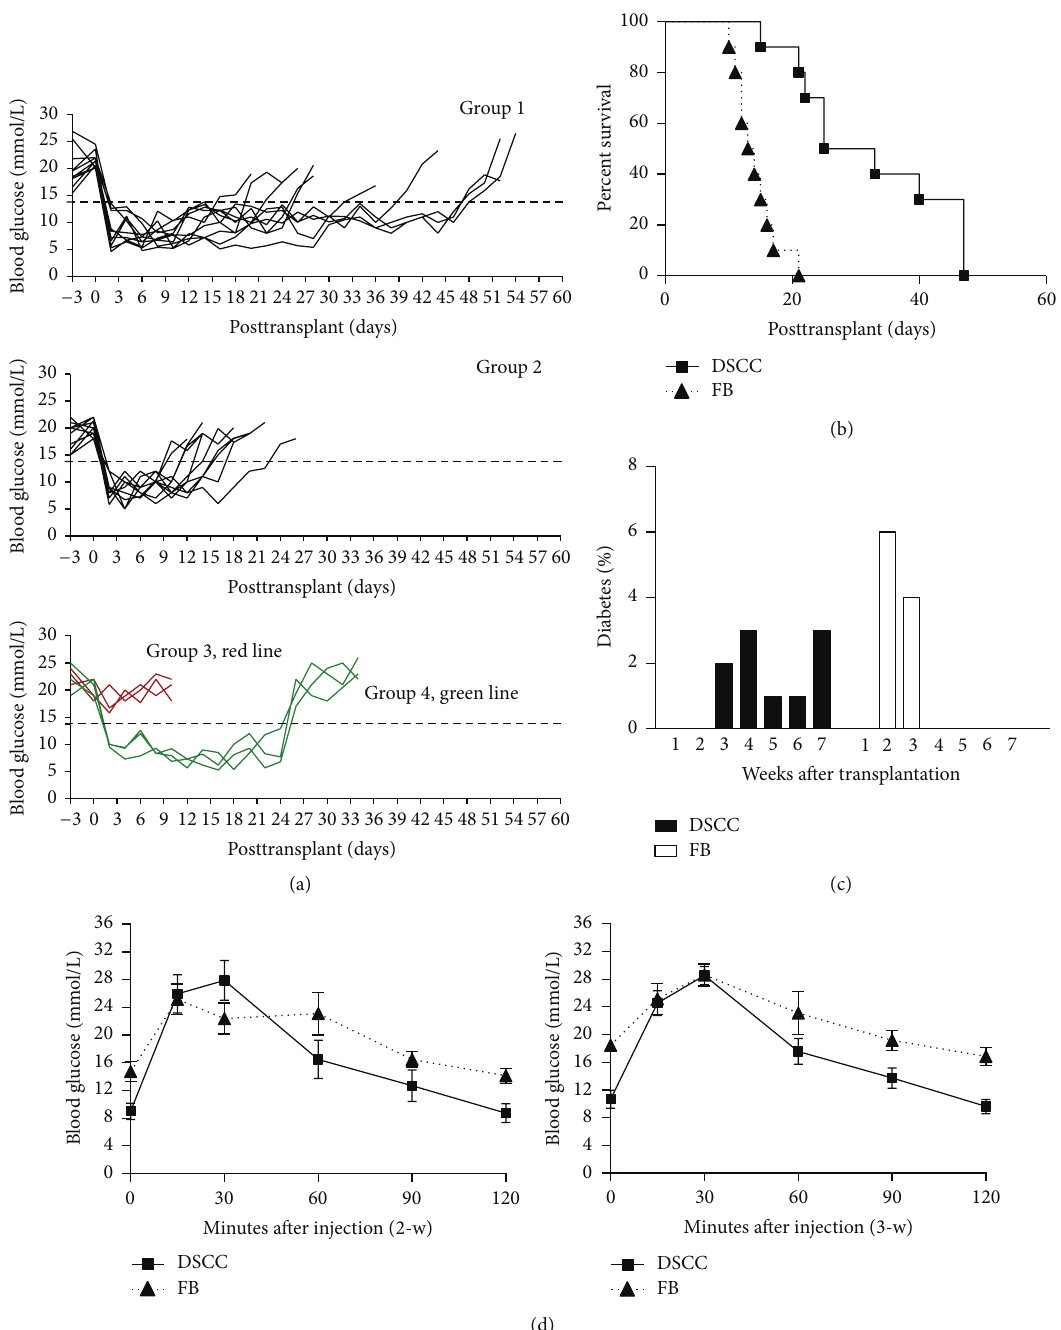
Figure 2: DSCC prolongs mouse islet allograft survival. (a) Blood glucose level in B6 mice before and after transplantation. Diabetes was induced by a single injection of streptozotocin in B6 mice. Mice in groups 1, 2, and 4 returned to normal glucose levels after transplantation with 400 islets from Balb/c donors in a collagen matrix with DSCC (groups 1 and 4) or FB (group 2) cells. Mice in group 3 (DSCC only) did not normalize high glucose after transplantation (red line). (b) Significantly prolonged euglycemia in diabetic B6 mice transplanted with DSCC and islets (black squares) was observed compared to that in mice with FB and islets (black triangles) ( 𝑛 = 10 , mean 32.2 versus 14.1 days, resp.). Kaplan-Meier graft survival curve is derived from blood glucose data, with 𝑃 < 0.001 by the log-rank test. (c) Distribution of developing graft failure after transplantation is shown in (c). 𝑦 -axis shows the numbers of mice that developed diabetes after transplantation. One week = day 1 to 7; 2 weeks = day 8 to 14; 3 weeks = day 15 to 21; 4 weeks = day 22 to 28; 5 weeks = day 23 to 35; 6 weeks = day 36 to 42; and 7 weeks = day 43 to 49. (d) Intraperitoneal glucose tolerance test results in B6 recipients transplanted with DSCC and islets ( 𝑛 = 6 ) 2 and 3 weeks after transplant (black squares) were compared to the FB and islets transplanted group ( 𝑛 = 6 ) (black triangles). Data are expressed as means ± SE; a better response was found at both time